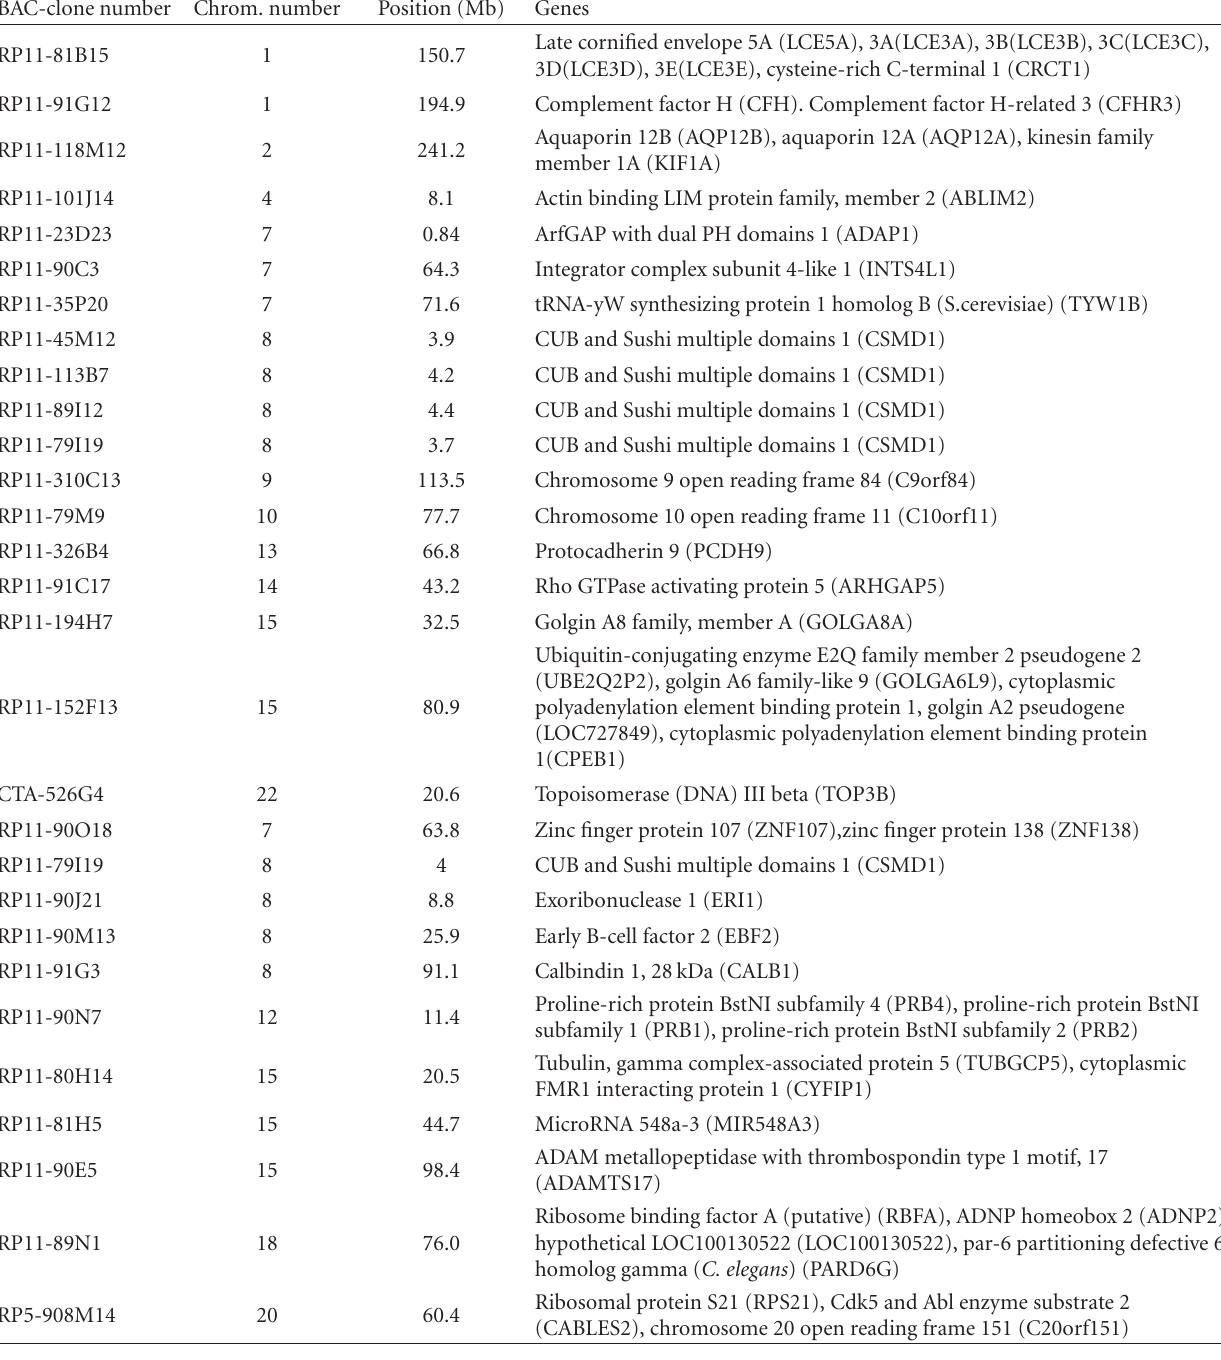
Table 3: Genes in BAC clones with CNVs.